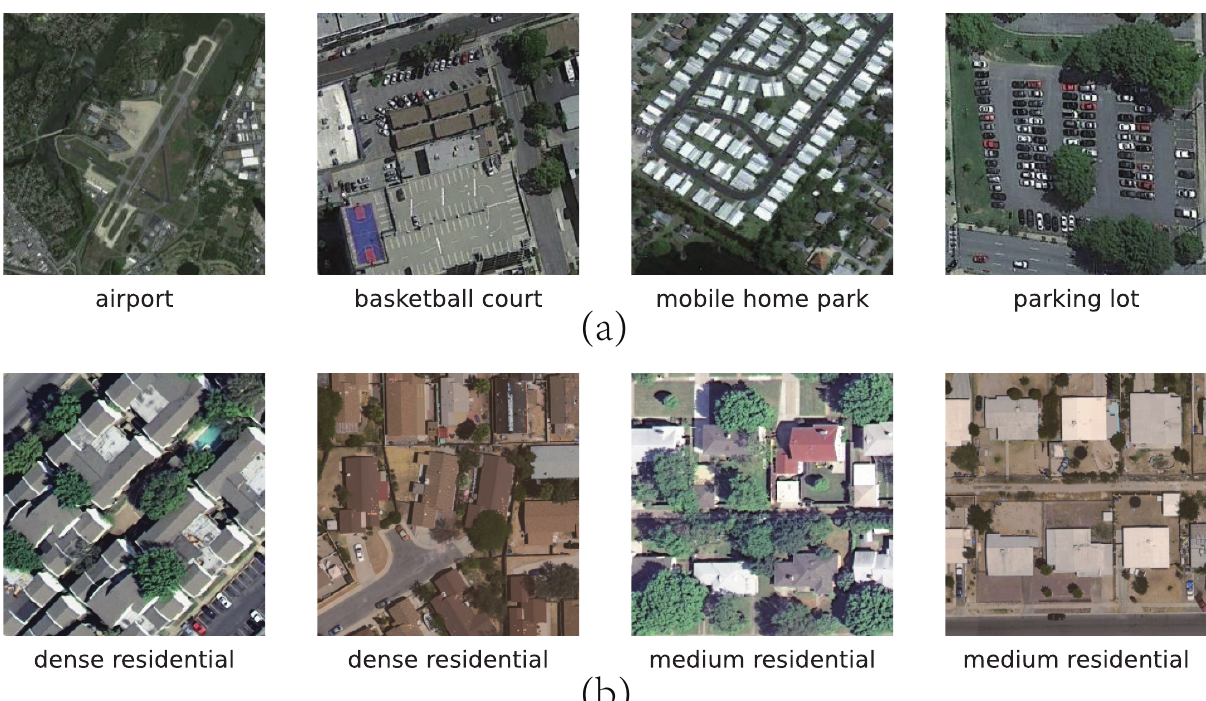
Figure 1. The challenges in RSISC: ( a ) complex spatial arrangement, and the coexistence of multi- ple ground objects; ( b ) high interclass similarity. The images are from the UC Merced Land-Use dataset [20] and the NWPU-RESISC45 dataset